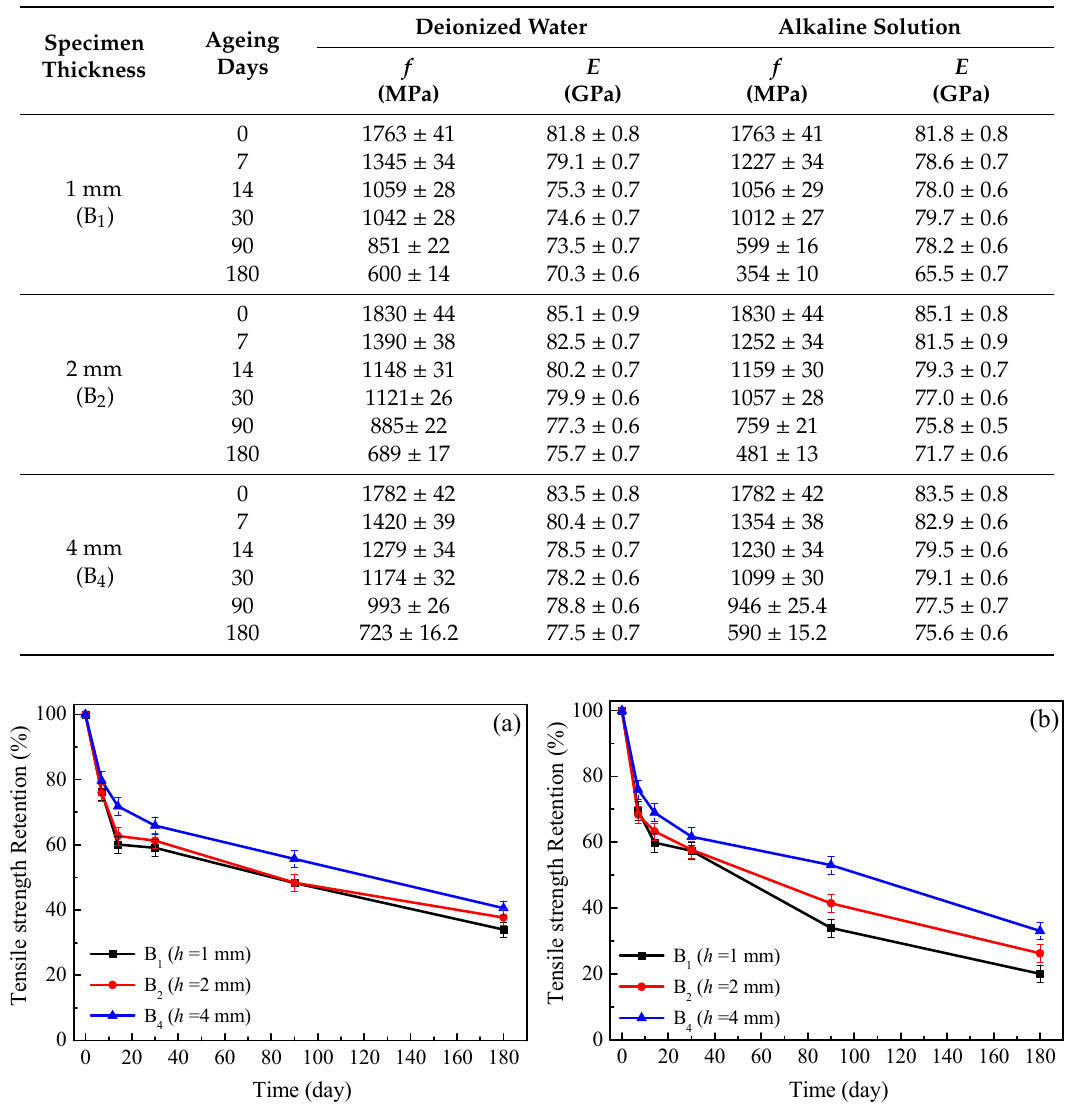
Table 2. Degradation of tensile strength ( f ) and elastic modulus ( E ) of BFRP laminates with different thicknesses.